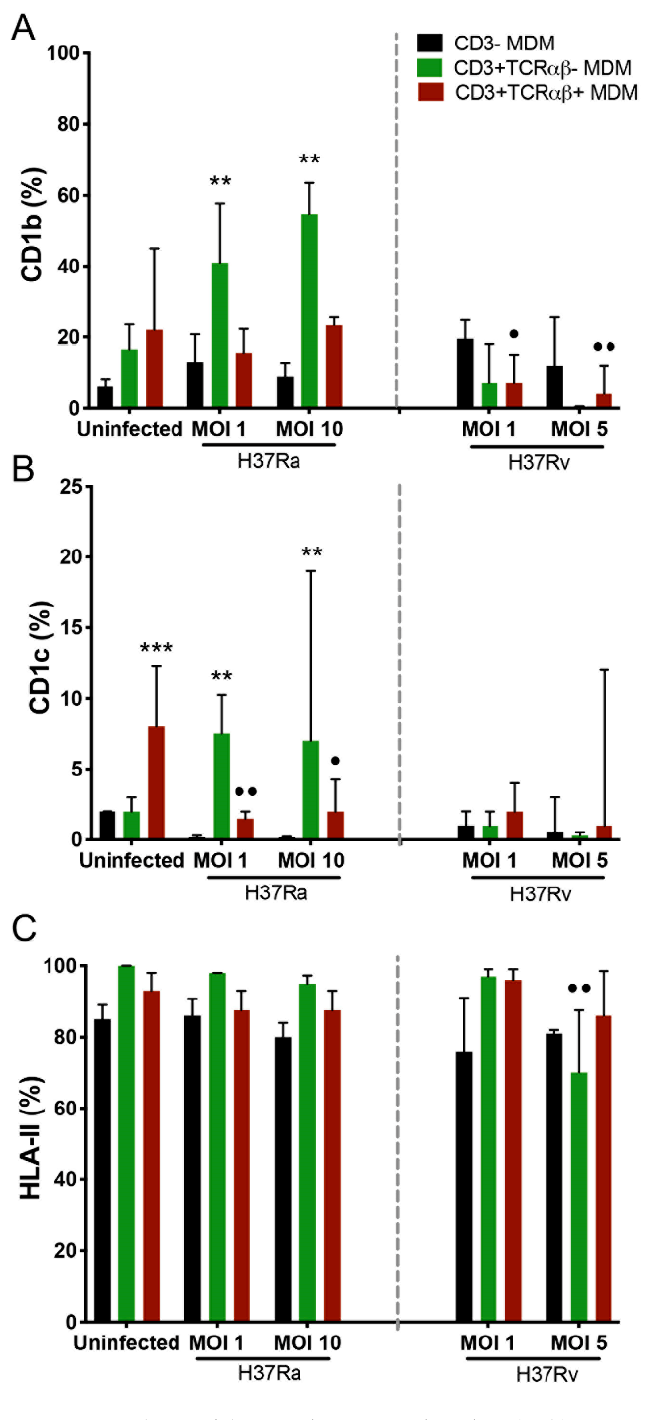
Figure 2. Virulence of the Mycobacterium tuberculosis (Mtb) strain modulates the expression of antigen- presenting molecules on CD3 + TCR αβ + and CD3 + TCR αβ − monocyte-derived macrophage (MDM) subpopulations. After 7 days in culture, 2 × 10 6 MDMs (per condition) were infected, and at 24 h post-infection, they were recovered for flow cytometric analysis. Frequency of Mtb-infected MDM subpopulations expressing CD1b ( A ), CD1c ( B ), and HLA-II ( C ) molecules. Bar graphs show median values and interquartile ranges (IQRs, 10–90) from four independent experiments. Kruskal–Wallis tests followed by Dunn’s post-tests were performed to compare macrophage subpopulations under the same MOI conditions versus CD3 − MDM subpopulation, ** p < 0.01, *** p < 0.001, and to compare the infected macrophage subpopulation versus its counterpart under uninfected condi-